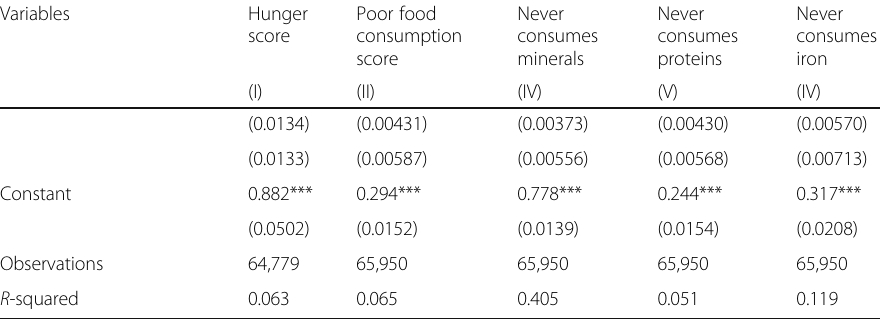
Table 5 OLS estimates of the impact of gender on food security (Continued) Variables Hunger